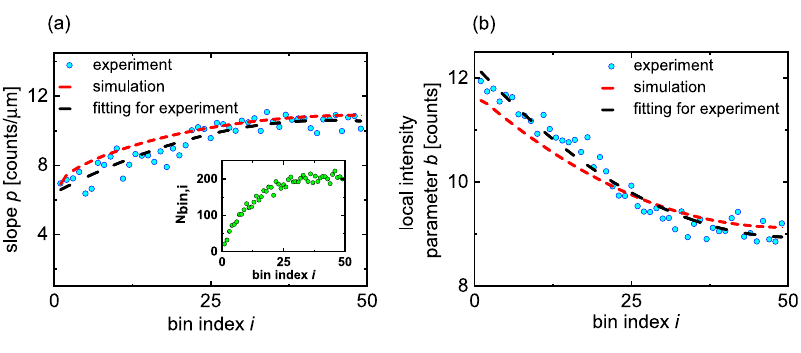
Figure 4: Dependence of (a) slope and (b) local intensity parameters ( p and b ) on bin index along the x -direction. The cyan dots and the black line refer to the data obtained from the tracked data and the corresponding 2nd order polynomial fi t. The red lines result from the fi nite element simulation. The corresponding number of available frames used in the respective bin N bin, i is plotted in the inset of (a).